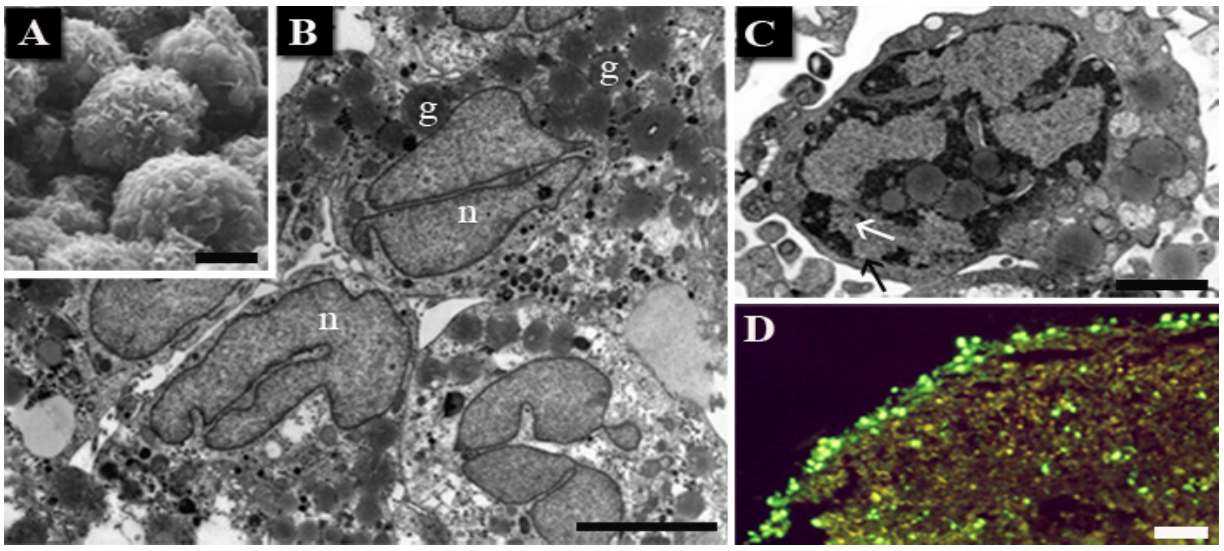
Figure 3. Untreated chondrocytes at SEM ( A ) and TEM ( B ). Condensed chromatin can be observed after UVB treatment ( C ), where pore translocation appears at diffuse chromatin level (arrows). Nuclear TUNEL-positivity is shown at fluorescence microscope ( D ). n: nuclei; g: lipid granules. Scale bars: ( A – C ) 5 µm; ( D ) 40